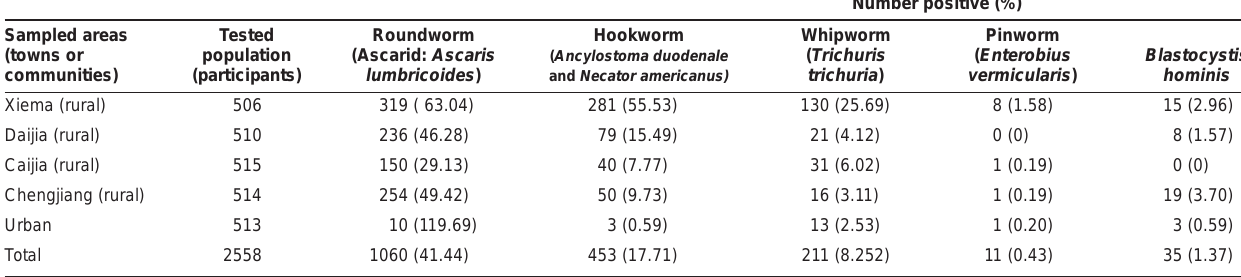
TABLE 1A Infectious rates of different parasitic species in Beibei, China Sampled areas